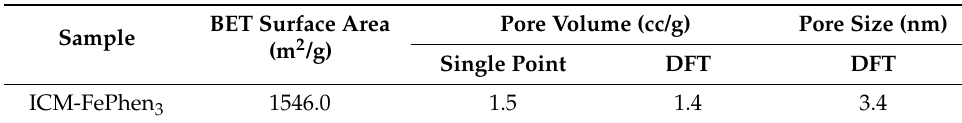
Table 3. Surface area, pore volume and pore size of ICM-FePhen 3 catalyst based on N 2 physisorption isotherm analysis.